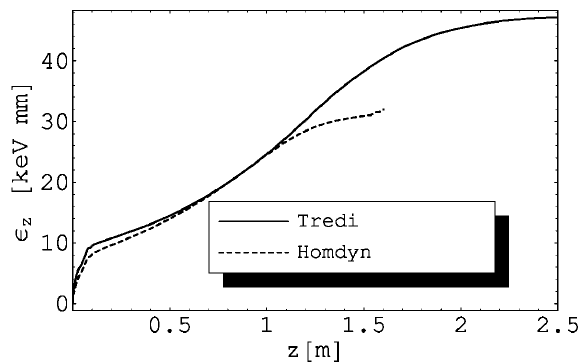
FIG. 11. Longitudinal emittance (keVmm).